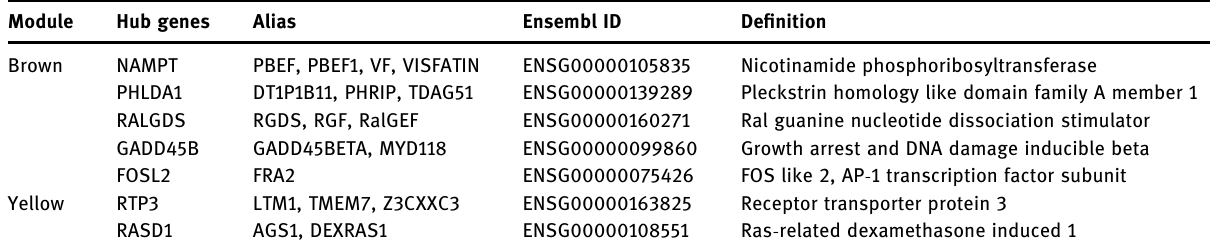
Table 1: List of hub genes. From top to bottom, hub genes in each module were arranged by the Kwithin from large to small Module Hub genes Alias